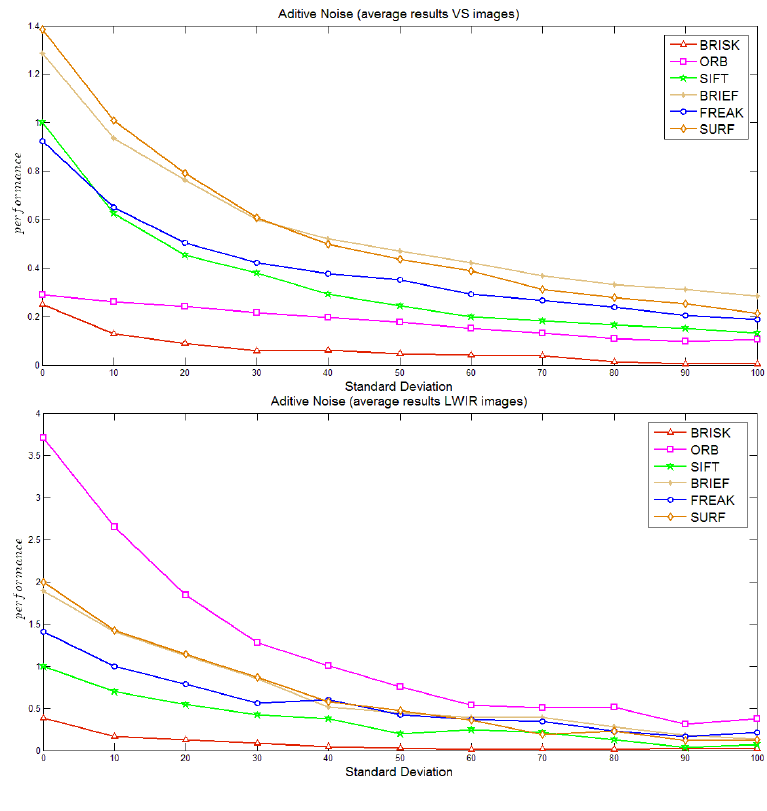
Figure 6. Noise case study: ( a ) visible spectrum; ( b ) LWIR